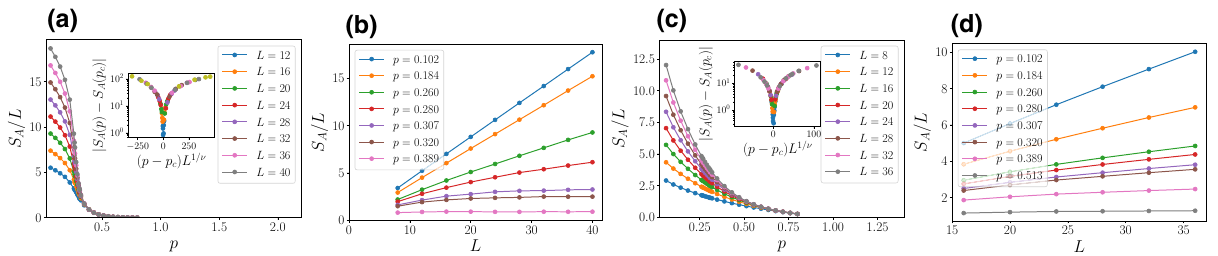
FIG. 4. (a) Long-time entanglement entropy S A of a subregion A of size L / 2 × L averaged over O ( 10 3 ) random realizations of the unitary circuit defined in Eq. (7) as a function of the probability p . The inset shows the scaling collapse across the critical point between a volume-law regime and an area-law regime with ( p c , ν) ≈ ( 0.28, 0.38 ) . (b) S A / L for the same system as in (a) as a function of L for various values of p . For small p , S A / L ∼ L , i.e., S A ∼ L 2 , while for large values of p , S A / L is independent of L , signifying area-law scaling. (c) Long-time entanglement entropy of a subregion of size L / 2 × L averaged over O ( 10 4 ) random realizations of the rotated nonunitary circuit [Eq. (8)]. The inset shows the scaling collapse with ( p c , ν) ≈ ( 0.28, 0.49 ) . (d) Plot of S A / L for the same system as in (c) as a function of L for various values of p . Again, for small p , S A / L ∼ L , i.e., S A ∼ L 2 , while for large values of p , S A / L is independent of L